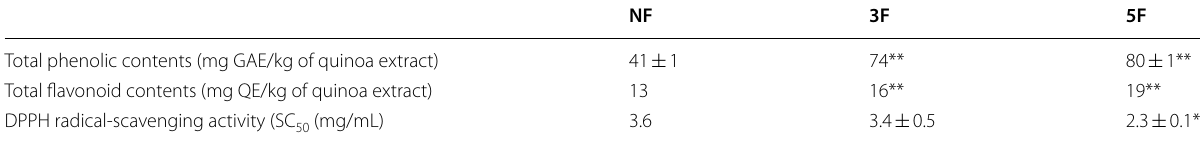
( NF non-fermented, 3F 3 days, 5F 5 days of fermented quinoa extracts); (NF vs 3F and 5F, **p < 0.01)